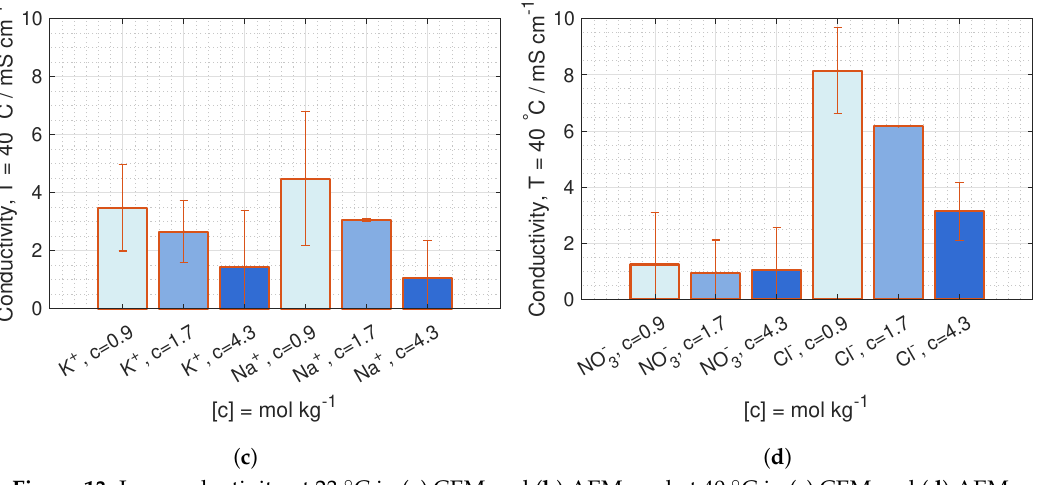
Figure 13. Ion conductivity at 23 ◦ C in ( a ) CEM and ( b ) AEM, and at 40 ◦ C in ( c ) CEM and ( d ) AEM, with 95% confidence interval.